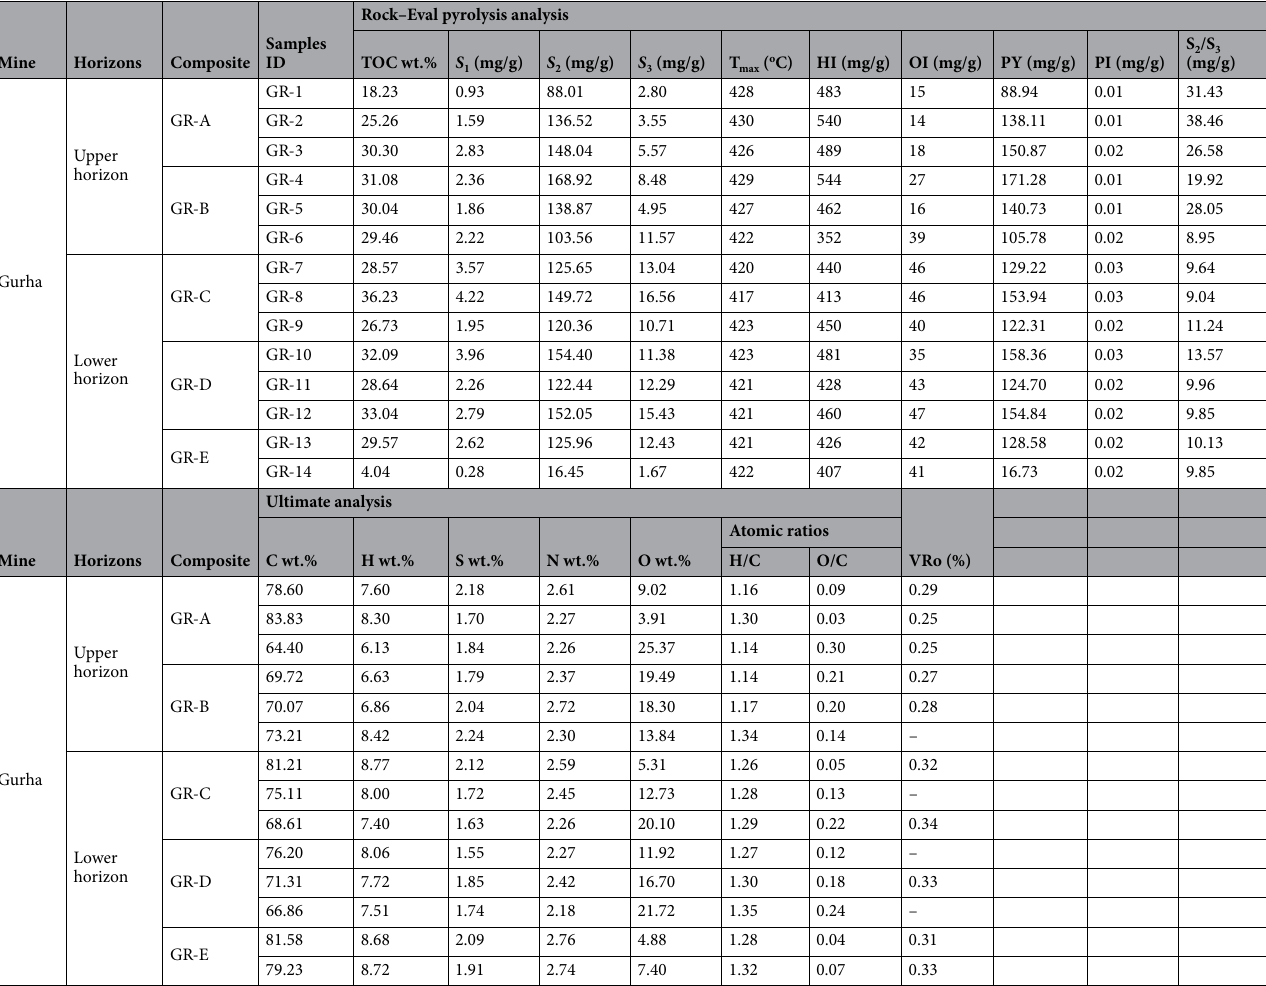
Table 1. Qualitative chemical results of TOC content, Rock–Eval pyrolysis and ultimate analyses of the fourteen Palana bituminous shales and huminite/vitrinite reflectance (%VRo) results for representative ten bituminous shale samples in the Gurha mines at Bikaner, Rajasthan. TOC, Total organic Carbon, wt.%; S 1, Volatile hydrocarbon (HC) content, mg HC/ g rock; S 2, Remaining HC generative potential, mg HC/ g rock; S 3 , carbon dioxide content, mg CO 2 /g rock; T max, Temperature at maximum of S 2 peak; OI, Oxygen Index =